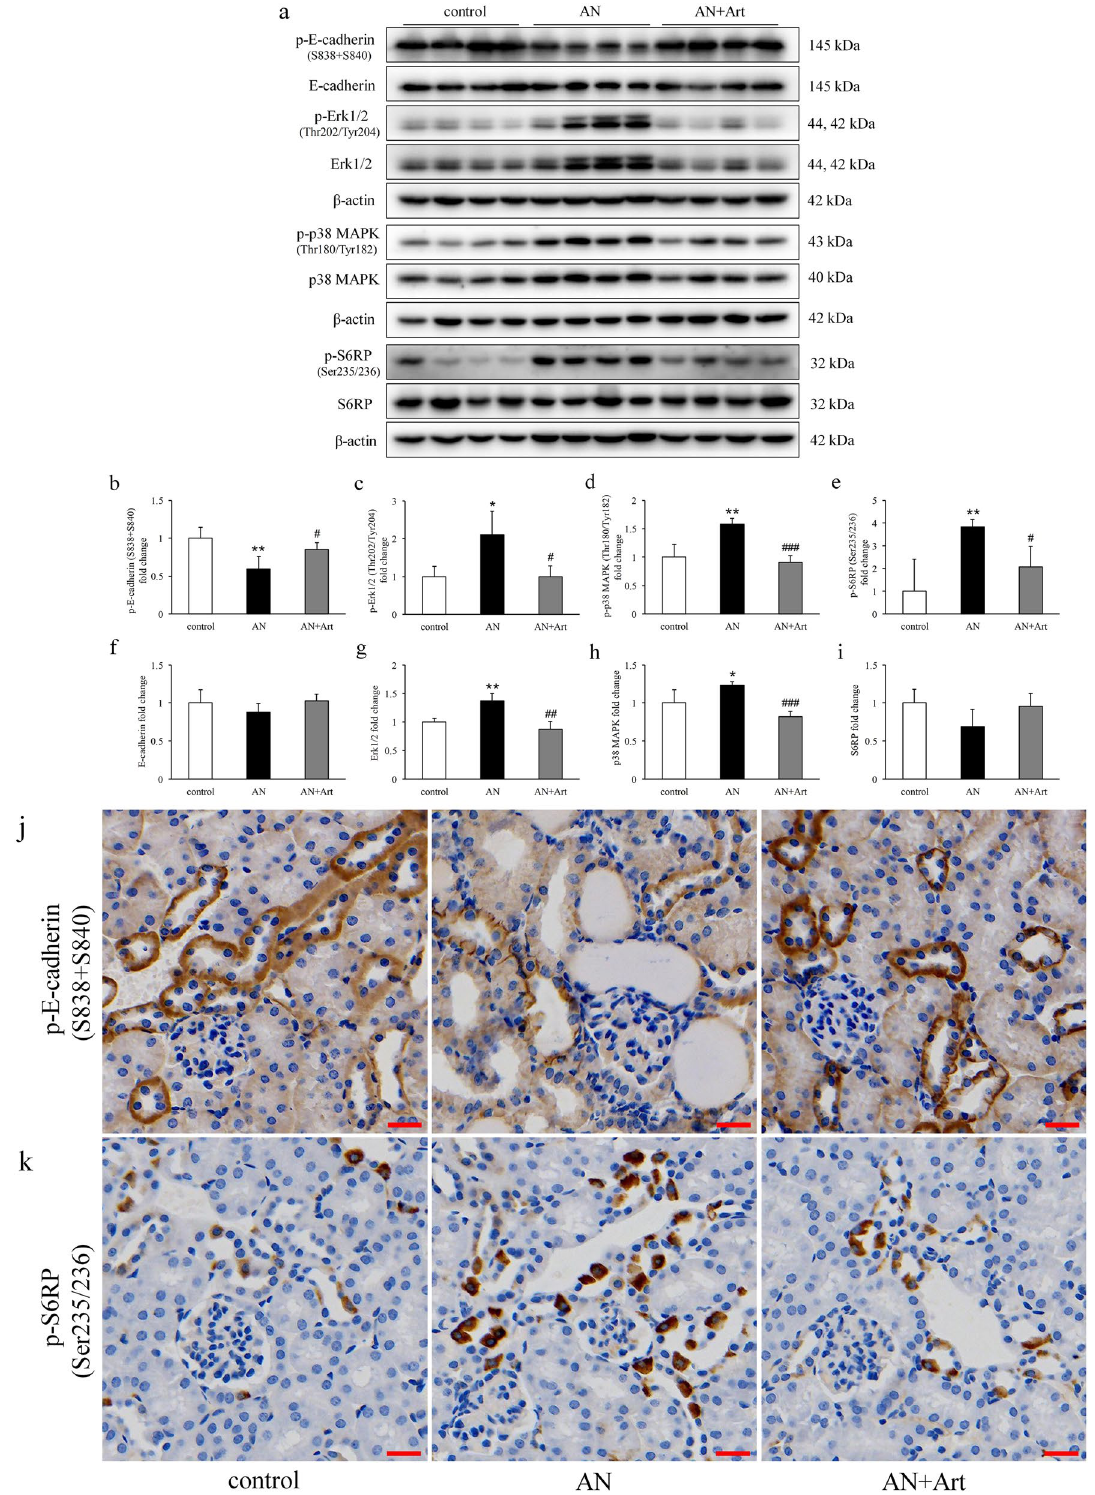
Figure 4. Effects of artemether on tubular cell phenotype and proliferation-related signalling pathways. ( a – i ) Western blot bands and quantitative analysis of p-E-cadherin (S838 + S840), E-cadherin, p-Erk1/2 (Thr202/ Tyr204), Erk1/2, p-p38 MAPK (Thr180/Tyr182), p38 MAPK, p-S6RP (Ser235/236), and S6RP in kidney in each group. ( j , k ) Representative immunohistochemical staining images of p-E-cadherin (S838 + S840) and p-S6RP (Ser235/236) in the kidney. Images showed that these proteins are predominantly expressed in renal tubules. Scale bar, 20 μm. n = 6 per group. * P < 0.05 and ** P < 0.01 versus control; # P < 0.05, ## P < 0.01 and ### P < 0.001 versus